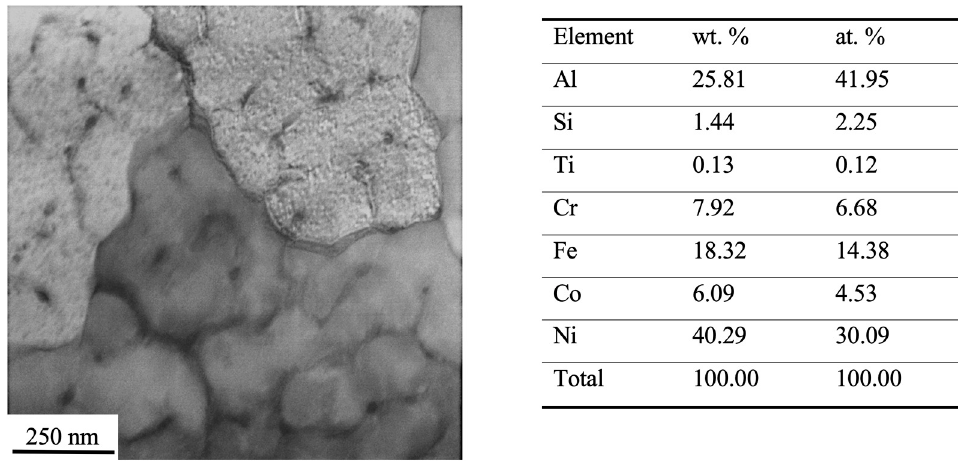
Figure 9. Electron-microscopic view of a HEA processed by a pulsed electron beam. The table presents the results of EDS analysis of the given foil zone.